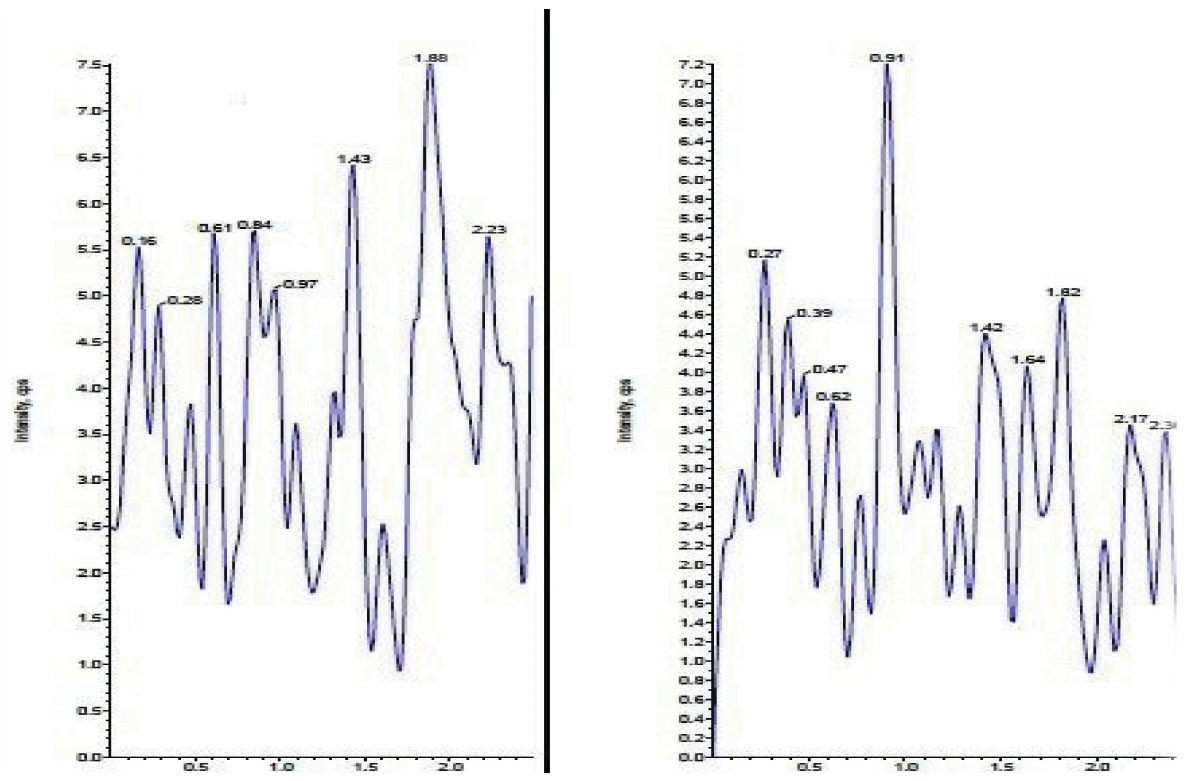
FIGURE 5 - MRM chromatogram of Blank human plasma.